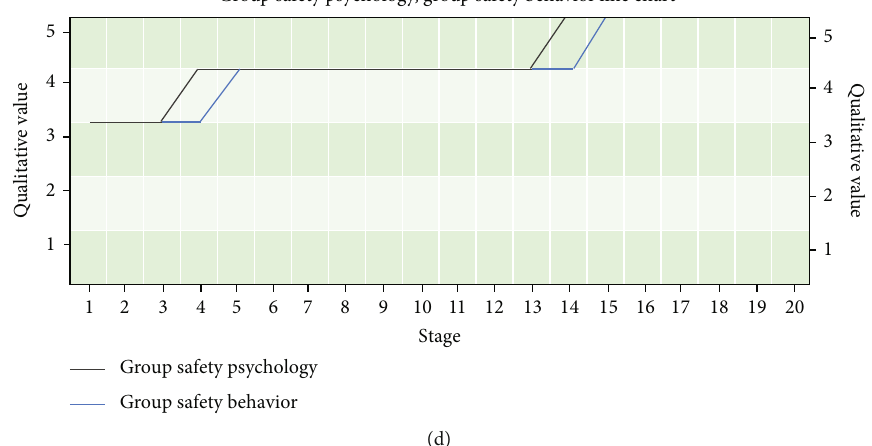
Figure 11: Simulation results and comparative analysis of Scheme 3. (a) Simulation result statistics. (b) Trend chart of group safety psychological change. (c) Trend plot of group safety behavior change. (d) Plot of comparison of trends in group safety psychology and behavior change.